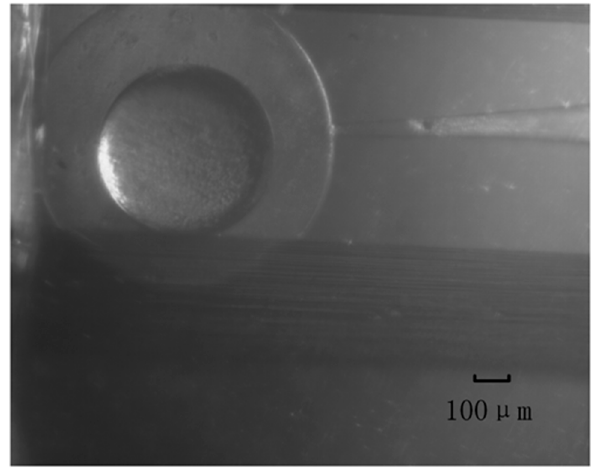
Figure 14. Zebrafish embryo before needle injection.